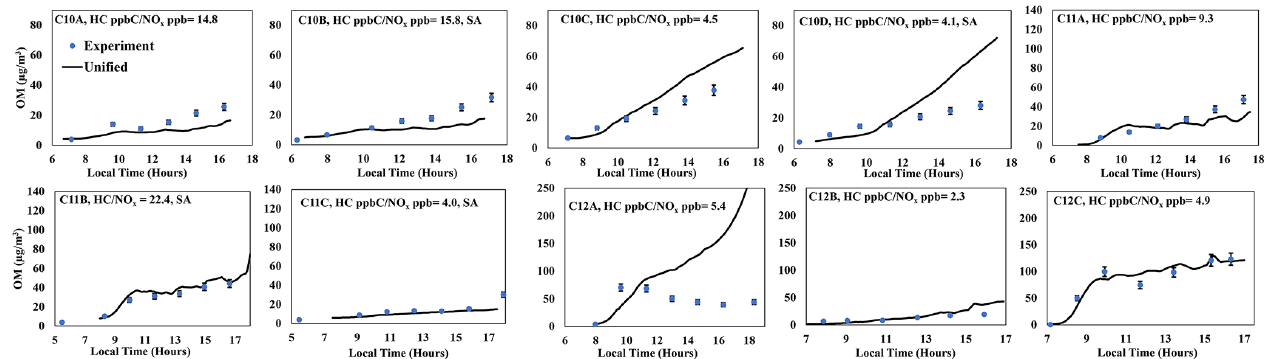
Figure 4. Comparison of SOA mass produced between simulations for C10, C11, and C12 using the unified product distributions based on the IVC (black line) to chamber data. The blue dots represent observed SOA data that are corrected for particle wall loss to the chamber. Error bars represent 9% uncertainty associated with the OC/EC and particle wall loss correction.